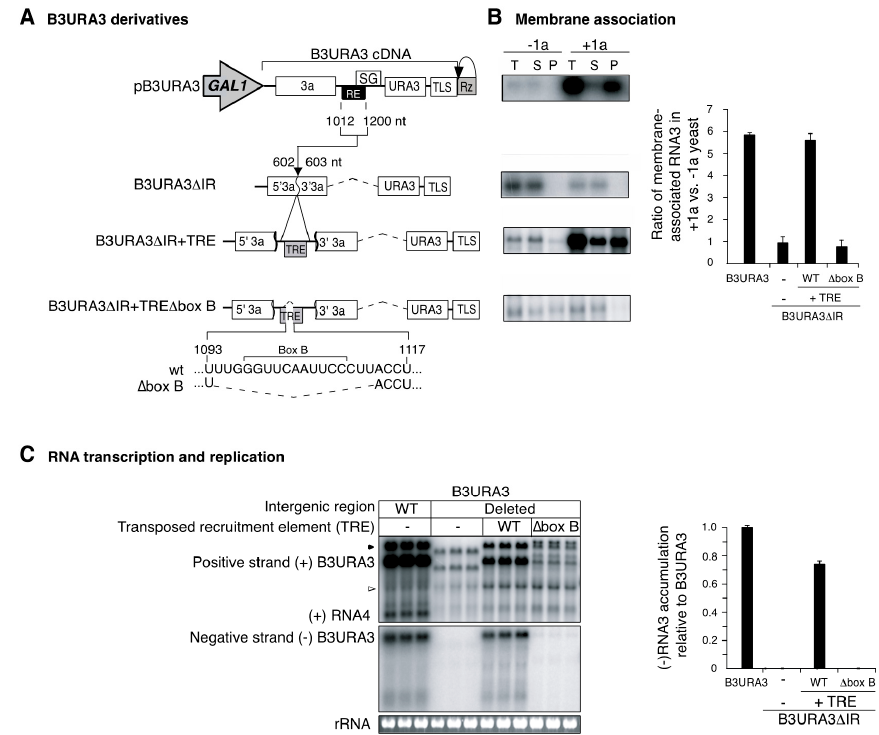
Figure 2. A transposed template recruitment element (RE) supports BMV RNA3 recruitment and replication. ( A ) Cassettes for in vivo transcription of B3URA3 and derivatives. The bracketed region represents a cDNA copy of B3URA3 flanked by a 5 ′ -linked GAL1 promoter and a 3 ′ -linked, self-cleaving, hepatitis delta ribozyme (Rz). Coordinates correspond to wt BMV RNA3. In B3URA3 Δ IR, a B3URA3 derivative lacking the intergenic region, RE sequences (nt 1012–1200) were inserted between nt 602 and 603, creating B3URA3 Δ IR + TRE. A box B-deficient TRE (B3URA3 Δ IR + TRE Δ box B) was created by removing nt 1094–1113; ( B ) Membrane association of B3URA3 derivatives in yeast expressing or lacking BMV replication protein 1a. After transcription for 72 h, equal amounts of cells were spheroplasted and lysed osmotically. Half of the lysate was processed to obtain the total RNA fraction (T). The other half was centrifuged at 10,000× g to yield a pellet (P) and supernatant (S) fractions. RNA was isolated from each fraction, and equal proportions analyzed by Northern blotting to detect positive-strand URA3 sequences. Representative blots are shown. The histogram shows the average and standard error from three replicates; ( C ) RNA replication in the absence of selection. Yeast was transformed with plasmids carrying B3URA3, or its derivatives, and with plasmids expressing 1a and 2a pol replication proteins. Transcription was induced with galactose for 72 h, and equal amounts of cells harvested for RNA extraction. Equal amounts of total RNA were analyzed by Northern blotting with a single-stranded, 32-P labeled RNA probe complementary to positive (+)- or negative ( − )-strand URA3. The solid arrowhead points to transcripts that have not been cleaved by the ribozyme. The empty arrowhead points to short transcripts formed after premature termination of transcription at the oligo(A) tract (Sullivan and Ahlquist, 1999). Ethidium bromide staining of 18S rRNA is indicated at the bottom. Negative-strand B3URA3 accumulation was quantified for three biological replicates. The histogram shows average and standard error relative to B3URA3. Although first isolated from brome grass, BMV replication, encapsidation, and recombination have been reconstituted in the yeast Saccharomyces cerevisiae by expressing viral replication and encapsidation proteins in combination with one or more genomic RNAs [10,28–30]. This system recapitulates all fundamental aspects of BMV replication in plants, including parallel dependence on